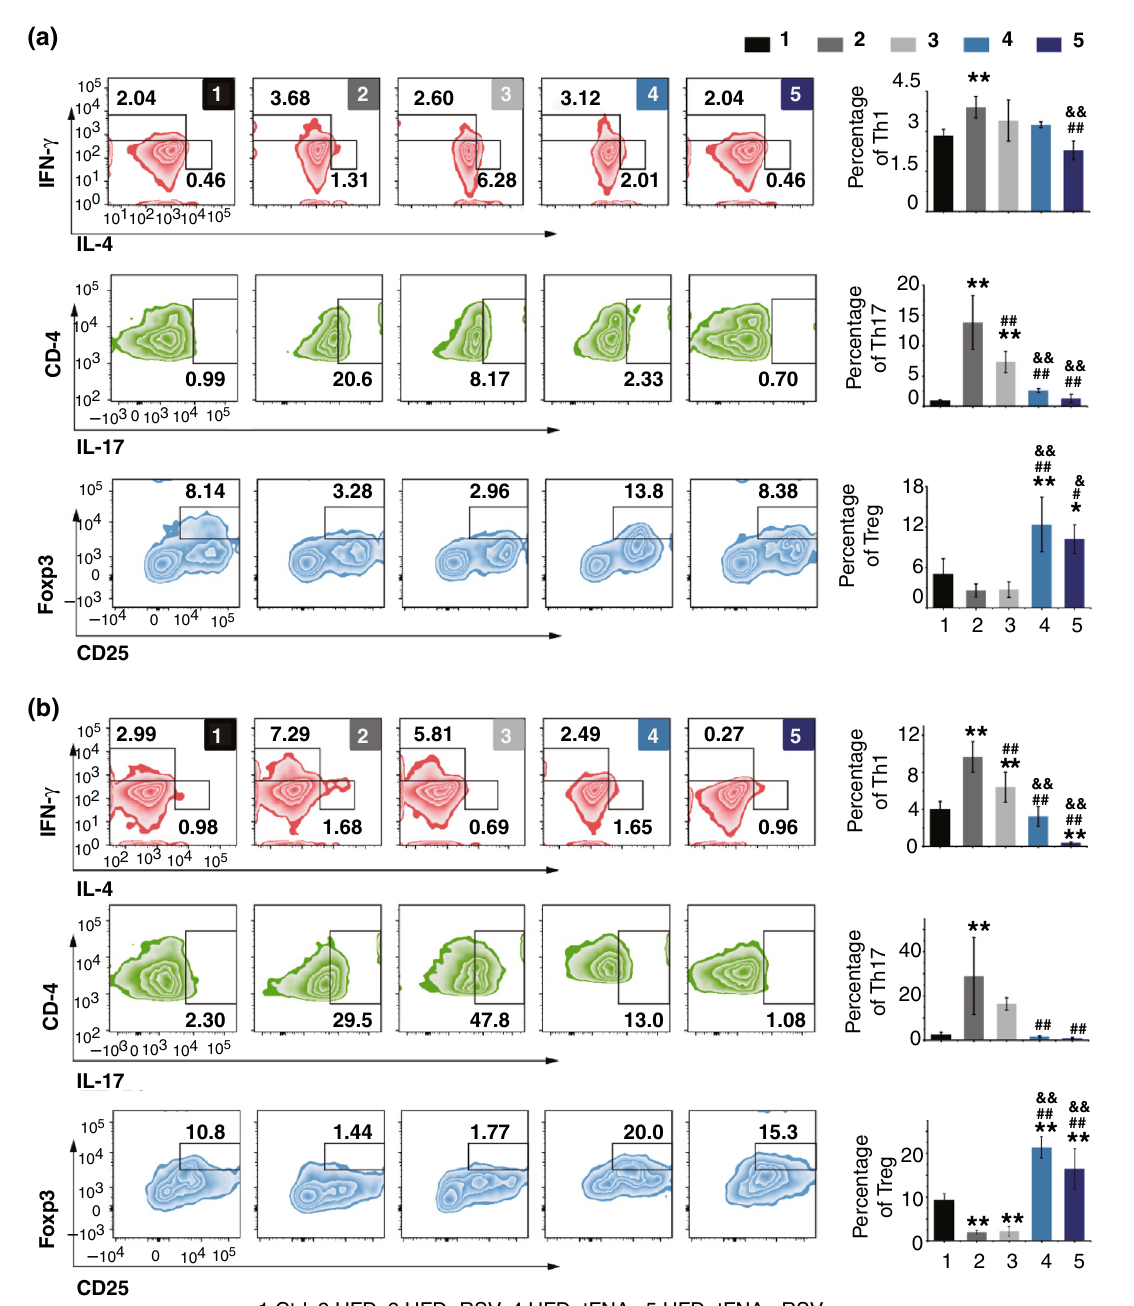
Fig. 6 tFNAs-RSV infusion regulated the adaptive immune state. a Flow cytometry result and statistical analysis of CD4 + lymphocytes sub- populations, Th1, Th2, Th17 and Treg, in peripheral blood leucocytes; b Flow cytometry result and statistical analysis of CD4 + lymphocytes subpopulations, Th1, Th2, Th17 and Treg, in spleen leucocytes. Data are performed using one-way analysis of variance (ANOVA) and presented as mean ± SD ( n ≥ 3). Statistical analysis: * compare with the control group, *P < 0.05, **P < 0.01; # compare with the LPS and IFN-γ group, # P < 0.05, ## P < 0.01; & compare with the control group, & P < 0.05, && P <